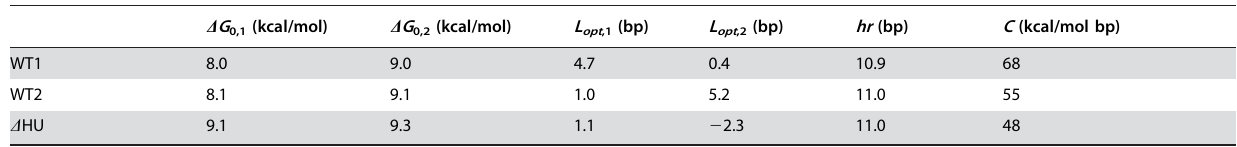
Table 1. In vivo values of the molecular parameters of the looped DNA- lac repressor complex. .. ... .... ... ... .... ... ... .... ... ... .... ... ... .... ... ... .... ... ... .... ... ... .... ... ... .... ... ... .... ... ... .... ... ... .... ... ... .... ... ... .... ... ...